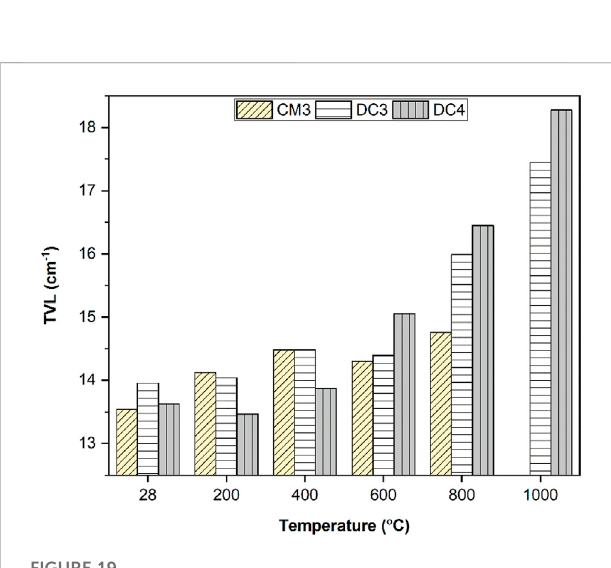
FIGURE 19 Tenth Value Layer (TVL) as a function of